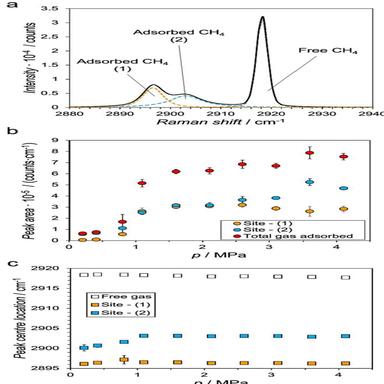
Measurement of methane adsorption on ZIF-7 at varying pressure. (a) Example spectra illustrating the deconvolution of peaks associated with C-H bond stretching for free and adsorbed methane, measured at 303 K and 1.6 MPa. (b) Area of peaks defined in (a) attributed to two kinds of adsorption sites (1 and 2, identified with a peak center location). (c) Peak center location of the methane species for a free gas phase and adsorbed phase methane on sites 1 and 2.